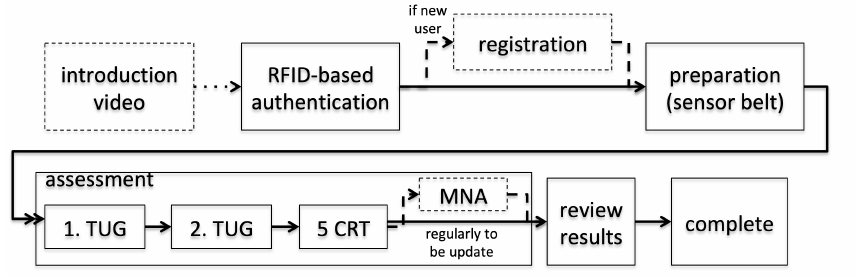
Figure 3. System’s user-interaction workflow; incorporating user-interaction phases and assessments. RFID tags are used for user authentication due to their confirmed usability for older adults [44,45] and compatibility with